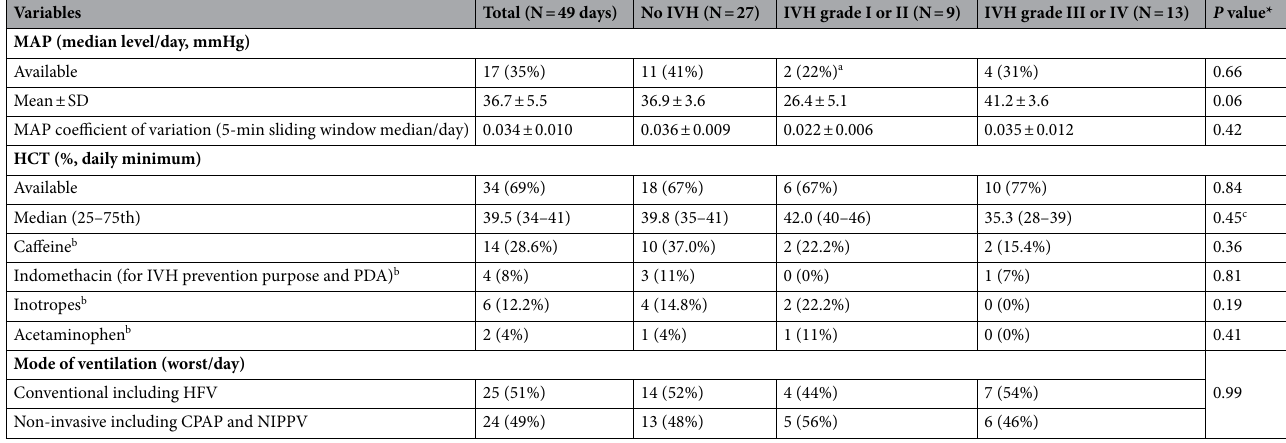
Table 2. Daily clinical variables during the studies among N = 49 days by IVH status. a The two measurements were from one subject; b Yes, if administered during the DCS measurement and within 1 h prior to the DCS measurement; * P values were obtained using a linear mixed model (when possible) to account for repeated measures in each subject. For categorical variables, the P-values were obtained using Fisher’s exact test without accounting for repeated measures in each subject.; c Square() transformation was applied. HCT Hematocrit percentage in the blood, CPAP continuous positive airway pressure ventilation, HFV high frequency (oscillation or jet) ventilation, NIPPV non-invasive positive pressure ventilation. Data are presented as n (column %) for categorical variables, except when presented as a mean ± SD for normally distributed variables or when presented as a median (25–75th) for non-normal variables.